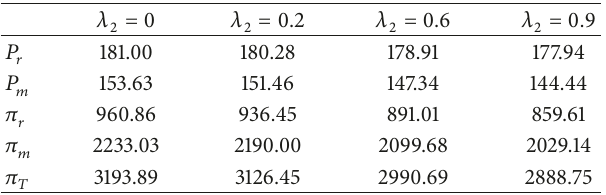
Table 2: The prices and profits with different level fairness concerns of manufacturer when 𝜇 = 0.6, 𝜆 1 = 0.2